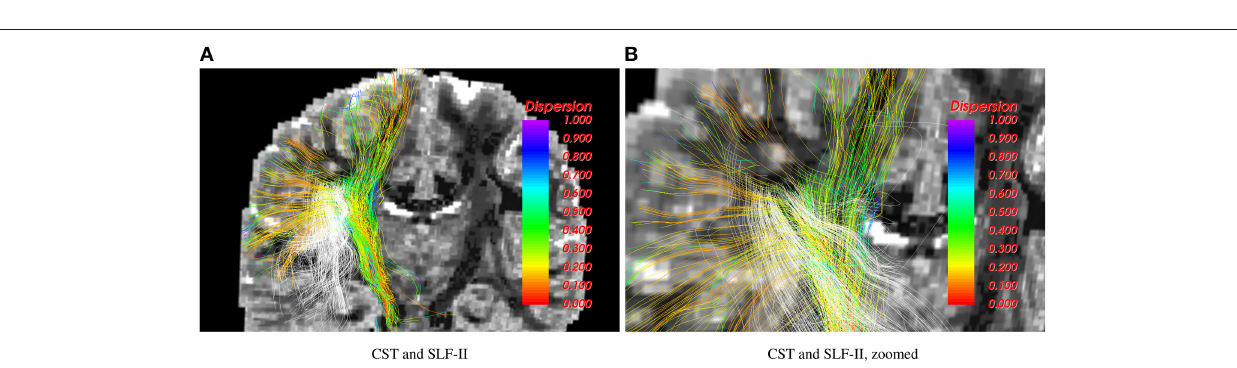
FIGURE 3 | Corticospinal tract (CST) and SLF-II traced using the 2-fiber NODDI model. Intersecting fibers are seen in the centrum-semiovale